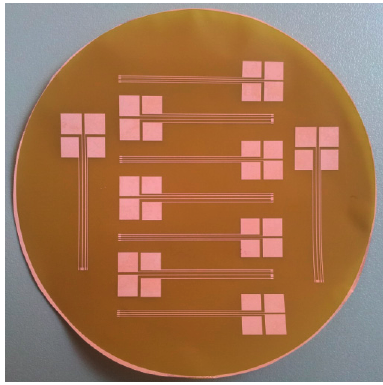
Figure 3. The Pyralux wafer after structuring the copper coating.